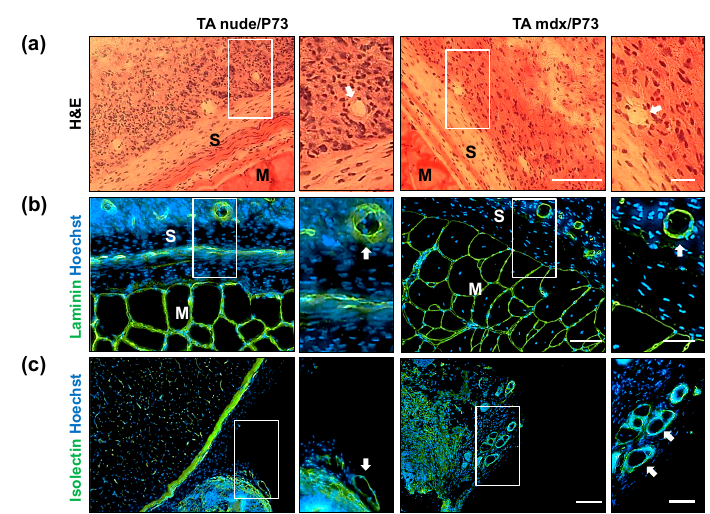
Figure 6. Vascularisation analysis of P73-implanted scaffolds. ( a ) H&E staining was performed on tissue collected from nude and mdx mice 6 weeks after P73 implantation. Immunofluorescence analysis ( b , c ) for laminin (green, b ) and isolectin (green, c ) showed the presence of capillaries and large vessels within the implanted scaffolds from nude and mdx muscles. Magnification areas (right panels) show detailed structures of vessels (white arrows), from rectangles. Nuclei are stained in blue with Hoechst. Scale bars: left panel a = 100 µm; right panel a = 25 µm; left panel b = 50 µm right panel b = 25 µm; left panel c = 100 µm; right panel c = 50 µm.